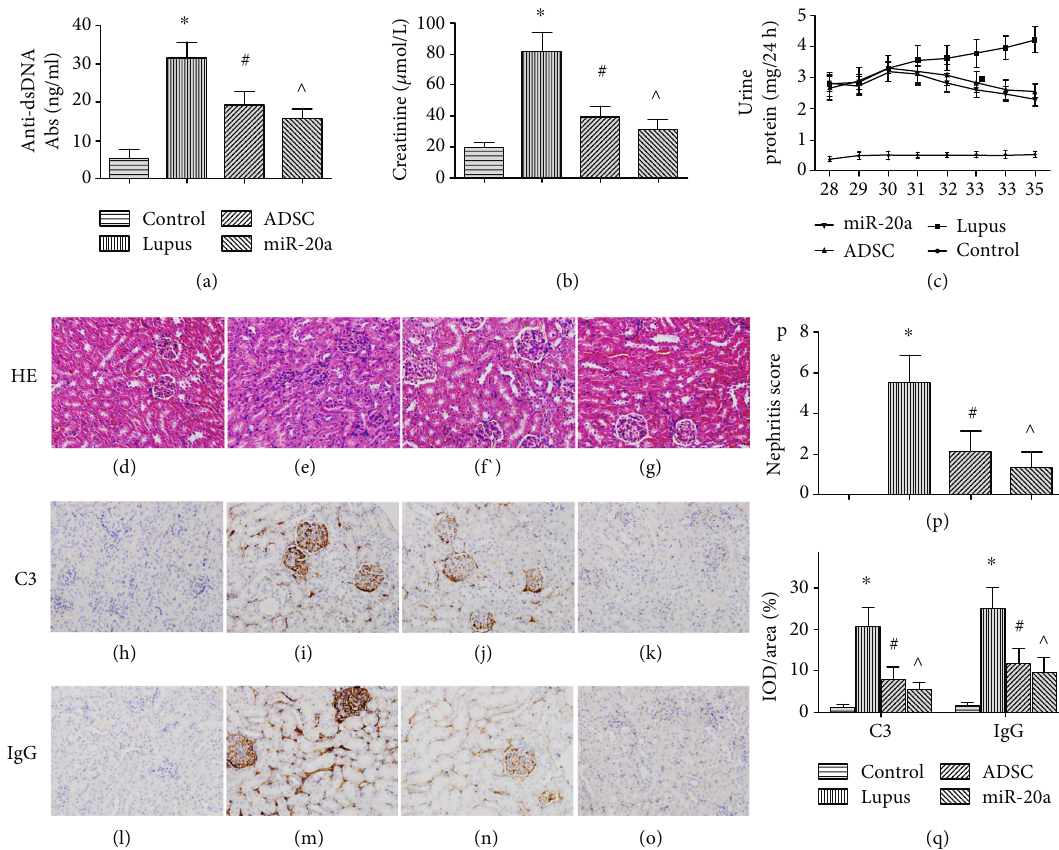
Figure 2: miR-20a-ADSC/ADSC treatment delays disease progression and reduces disease severity in murine LN: (a) anti-dsDNA, (b) serum creatinine, and (c) 24h urine protein. (d – o) Representative images of kidney sections stained with H&E and immunohistochemistry of the normal control group (d, h, and l), lupus group (e, i, and m), ADSC group (f, j, and n), and miR-20a group (g, k, and o). (p) Nephritis severity scores. (q) Measurement of C3- or IgG-positive cells using IOD/area. The data are expressed as the mean ± SD . ∗ P < 0 : 05 vs. control group; # P < 0 : 05 vs. lupus group; ^ P < 0 : 05 vs. ADSC group. Control: normal control group; lupus: lupus group; ADSC: adipose-derived stem cell group; miR-20a: miR-20a-ADSC